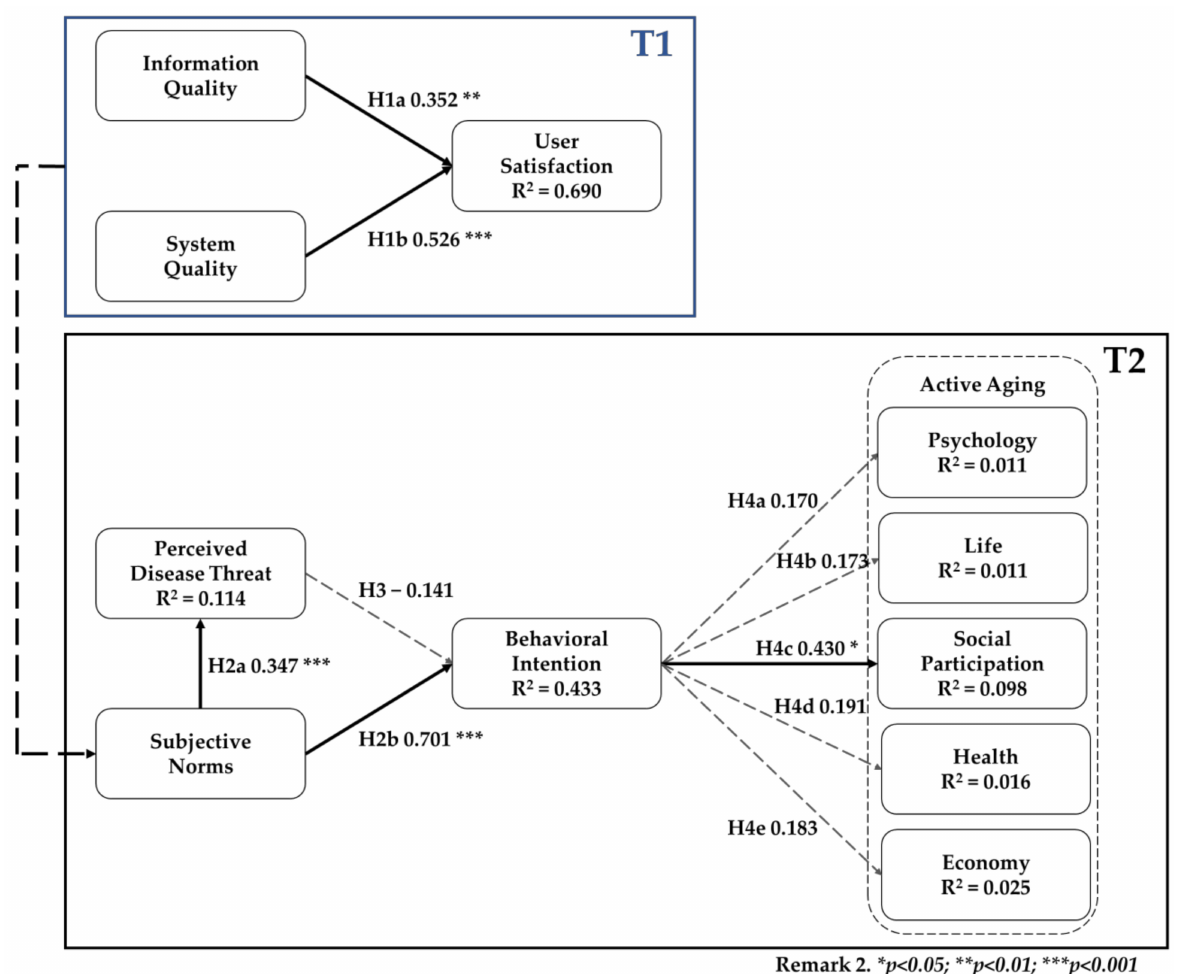
Figure 3. Results of the